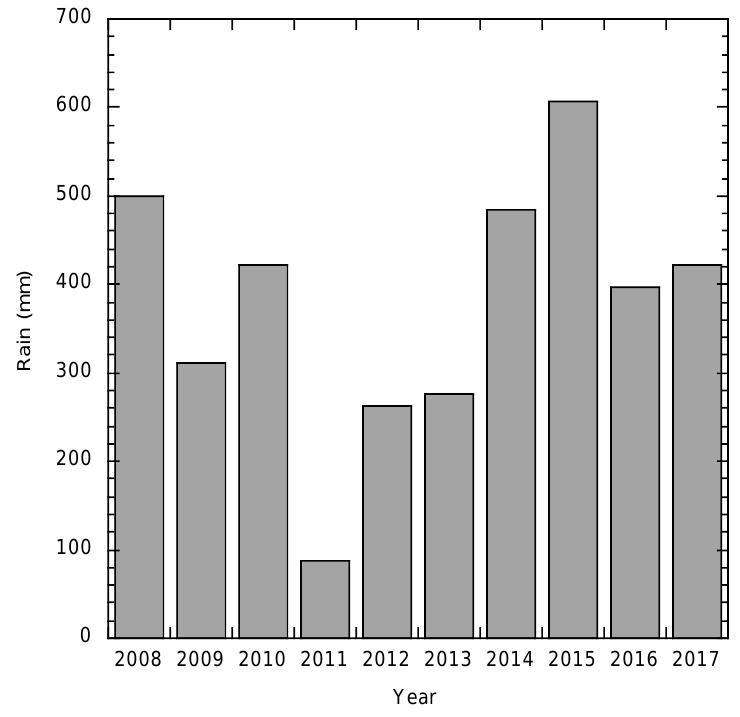
Figure 5. The seasonal rain totals for the study-site for the interval between DOY 90 and DOY 328. Note that the two years of the study, 2016 and 2017, are mid-range in rain for the season.